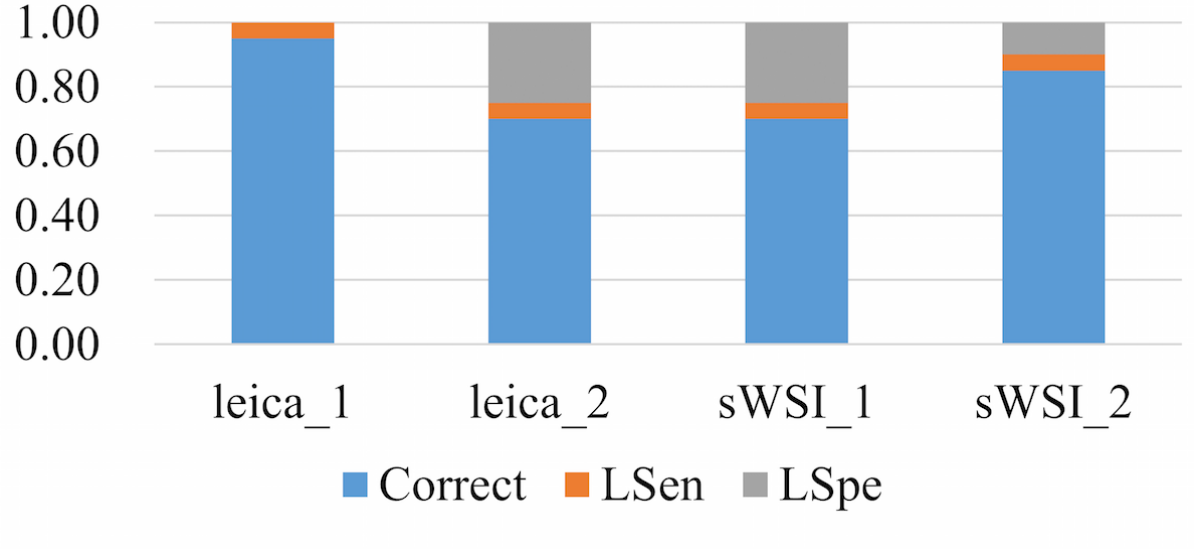
Figure 8. Performance based on scanner and sWSI virtual slides. Sample type: breast. LSen: low sensitivity; LSpe: low specificity.